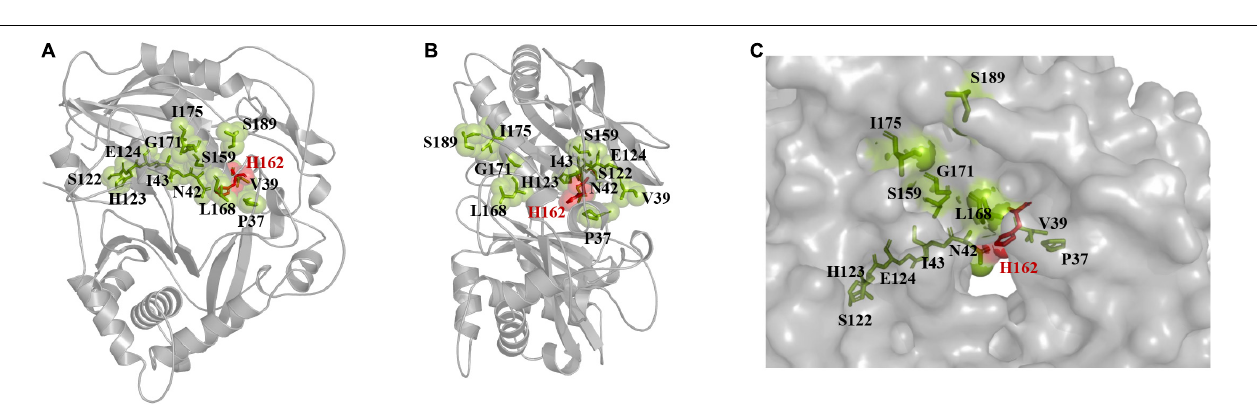
FIGURE 2 | “Hotspots” distribution was predicted by Hotspot Wizard 3.0. The center residue His162 is displayed as dots style and shown in red. The others are displayed as spheres styles and shown in green by PyMOL. (A) The front face of the model is displayed as cartoon style. (B) The side face of the model is displayed as cartoon style. (C) The distribution of residues near the solvent channel, the model is displayed as surface style.